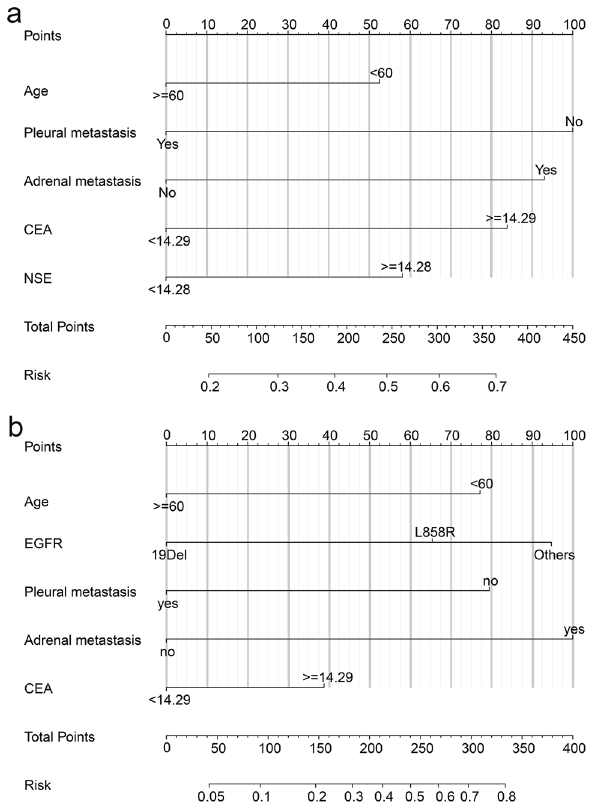
Figure 6. Nomogram for the prediction of PM ( a ) and LM ( b ).